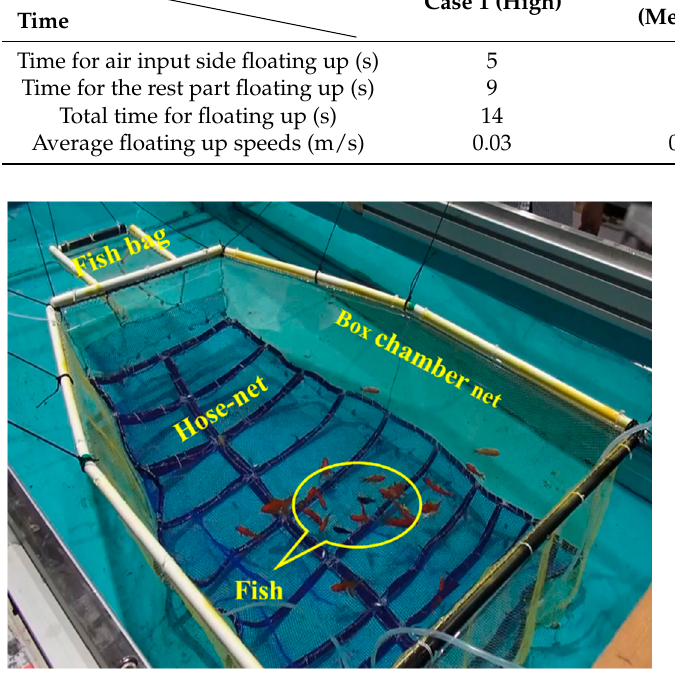
Figure 8. An example of the photographs captured during the experiment.